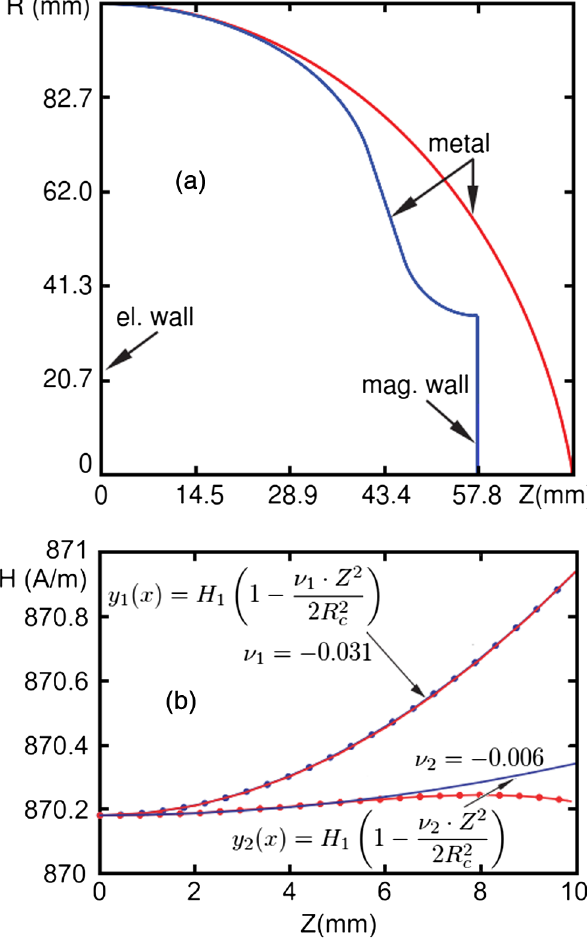
FIG. 9. Example of two cavities (a) with equal frequencies, equal R a , equal radii of curvature at the iris but having different β 2 and different behavior of the electric field on the iris (b). FIG. 10. Example of 2 cavities (a) with equal frequencies, equal